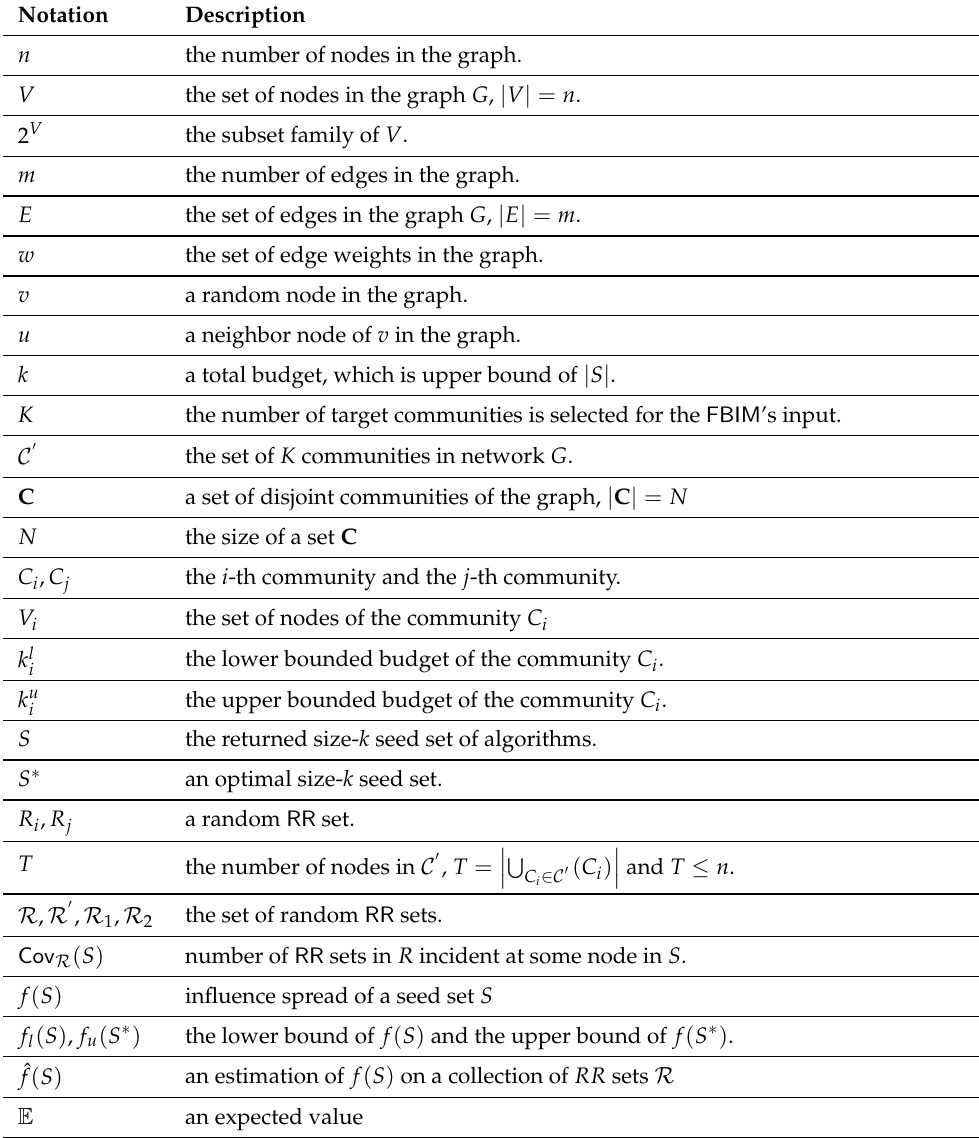
Table 1. Table of the usual notation used in the maximizing submodular problem under fairness